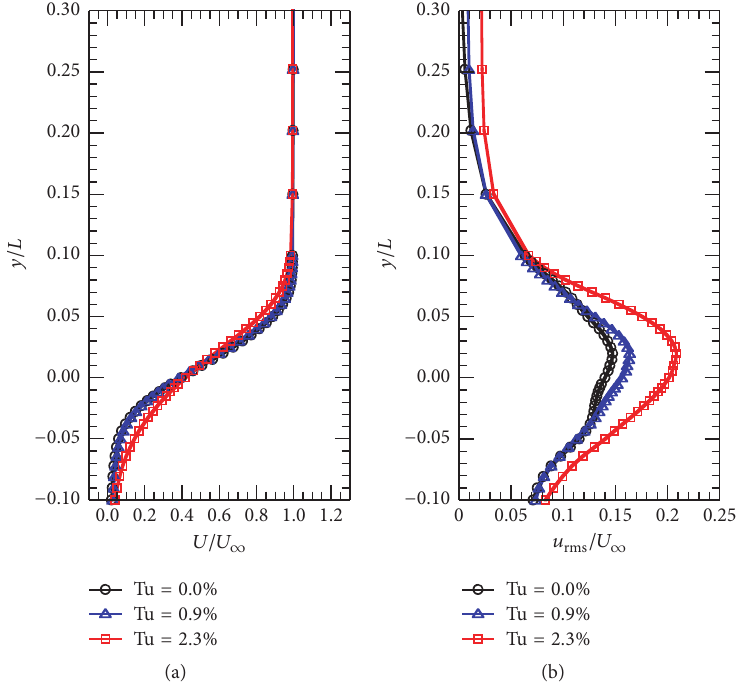
Figure 13: Predicted profiles of mean velocity (a) and turbulent intensity (b) for the cavity flow with 𝐷/𝐿 = 0.5 .